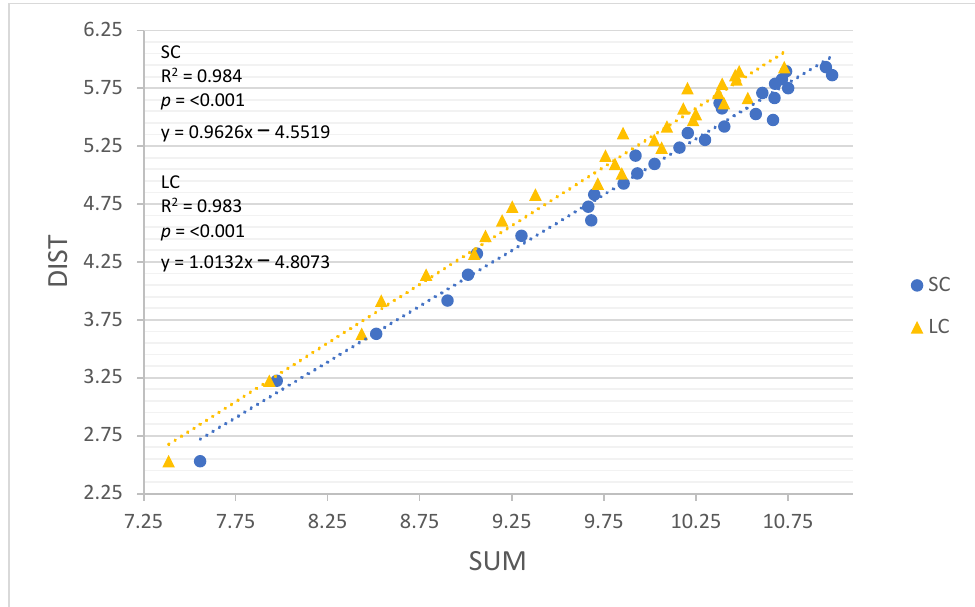
Figure 5. The relationship between log transformed DIST and SUM around the small circle and the large circle. SC = small circle, LC = large circle.